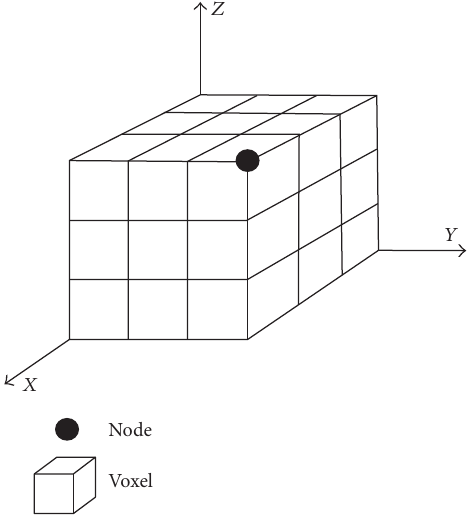
Figure 2: Sketch map of voxel